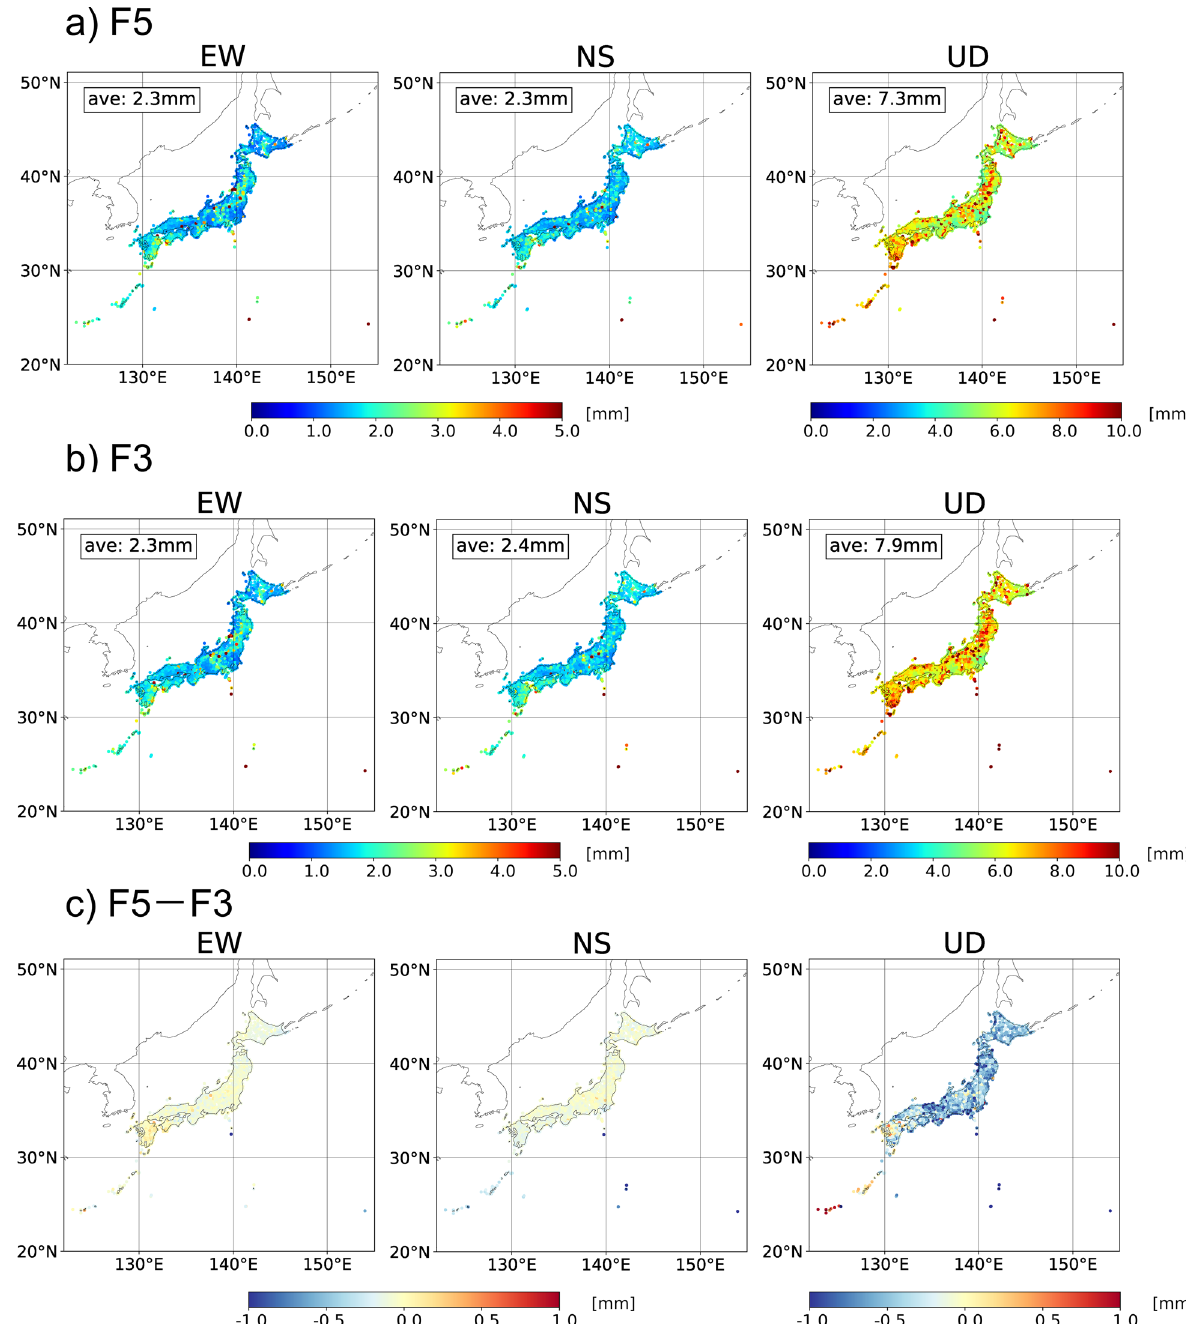
Fig. 8 RMS of baseline vector in 2019 by a F5, b F3 and c their difference (F5 minus F3). The baseline vectors with respect to Ishioka were formed and the linear signal was removed in advance of each RMS calculation. The RMS values averaged over every station are listed at the top left on